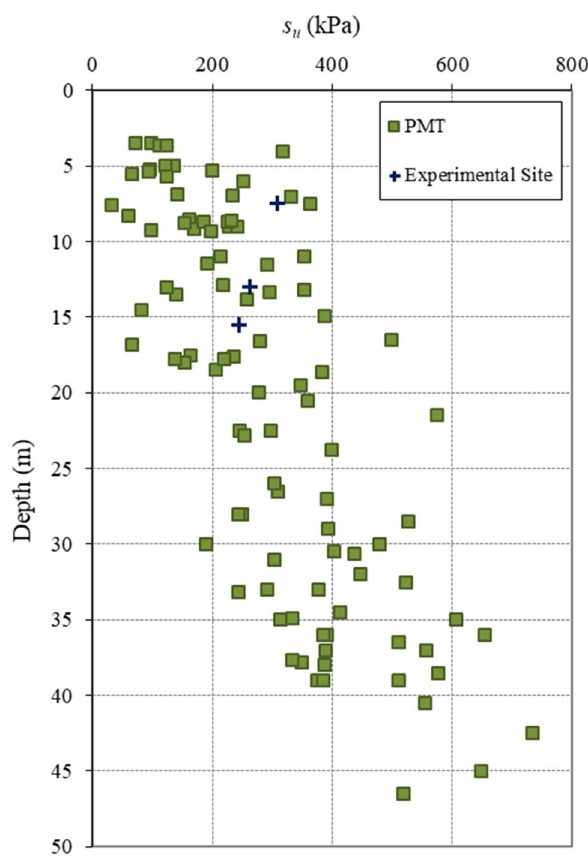
Fig. 12 Undrained shear strength obtained from PMT test